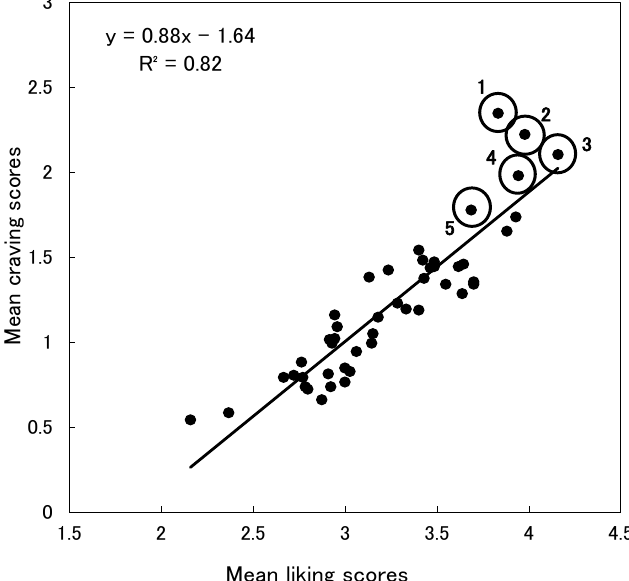
Figure 2. Scatter plot of the mean liking scores and the mean craving scores. y = 0.88x - 1.64